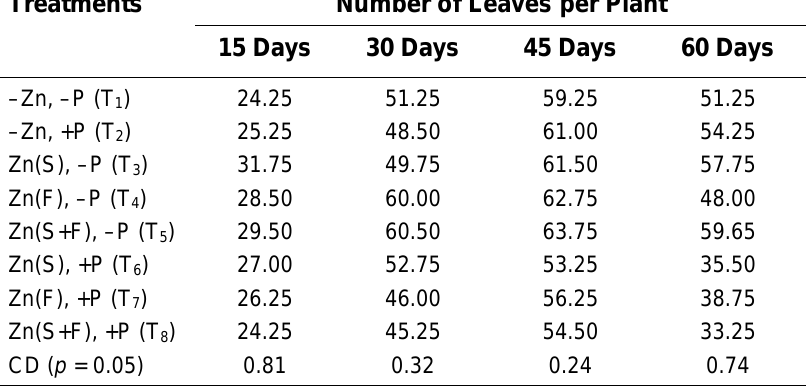
Interaction Effect Between Zn and P on the Number of Leaves per Plant of Stevia ( S. rebaudiana ) (Mean of Four Replications) Number of Leaves per Plant